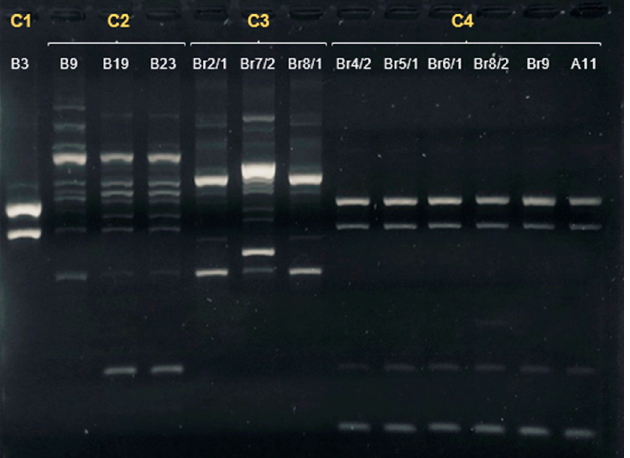
Figure 1. ERIC-PCR fingerprints of Campylobacter jejuni isolated in dogs. The ID of the sample is presented in white. The letter and numbers in yellow represent the cluster assigned to the profile. Table 2. ERIC-PCR, Sequence type, Clonal complex and flaA svr of Campylobacter jejuni isolates from dogs studied by whole genome sequence.